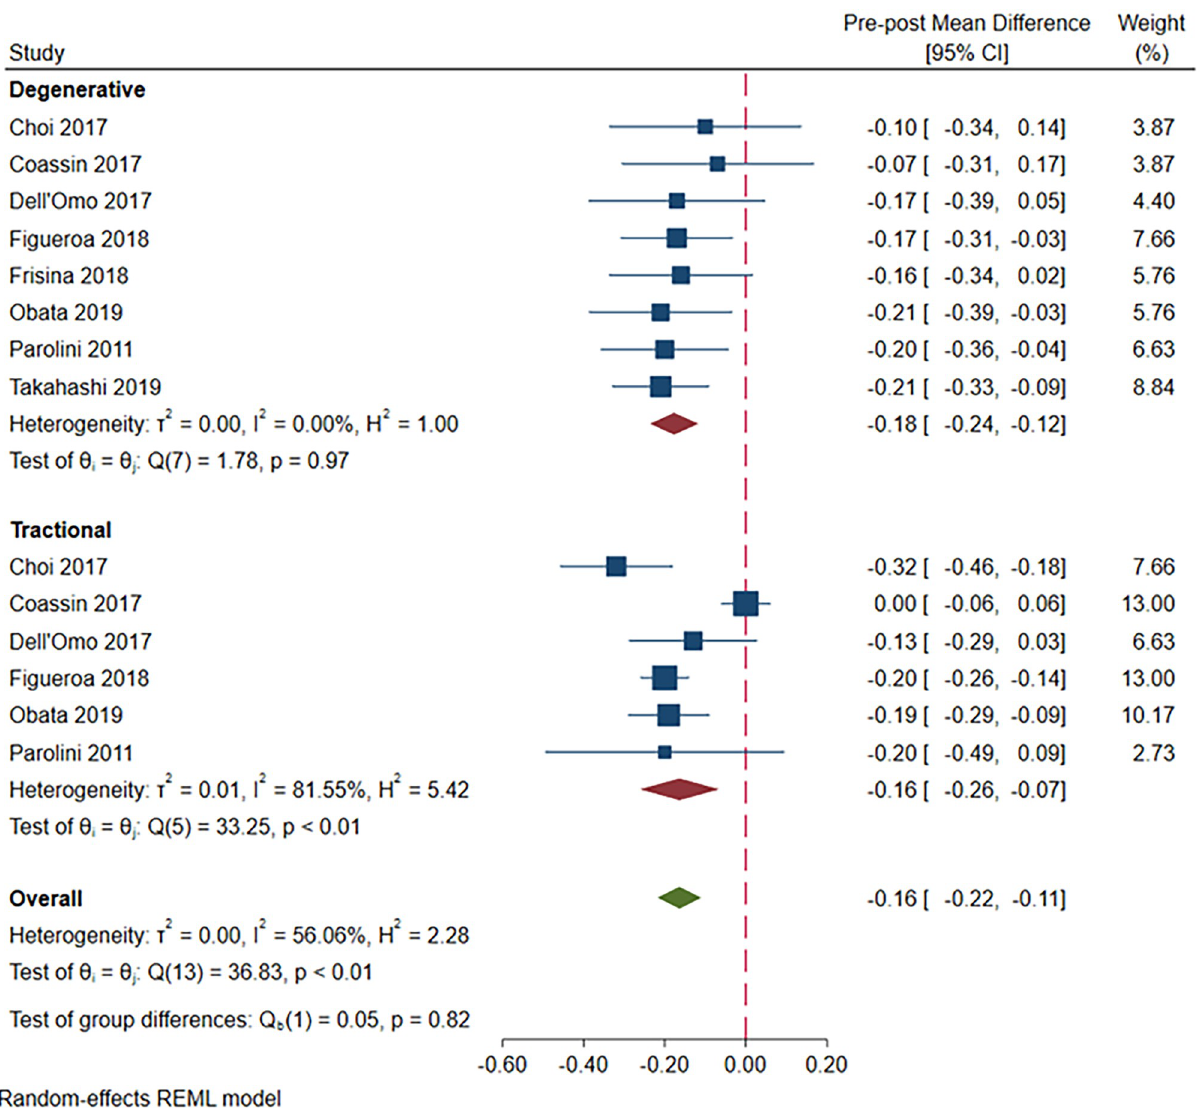
Fig 3. A forest plot showing pre-post mean difference in BCVA in the degenerative LMH group versus the tractional LMH group.